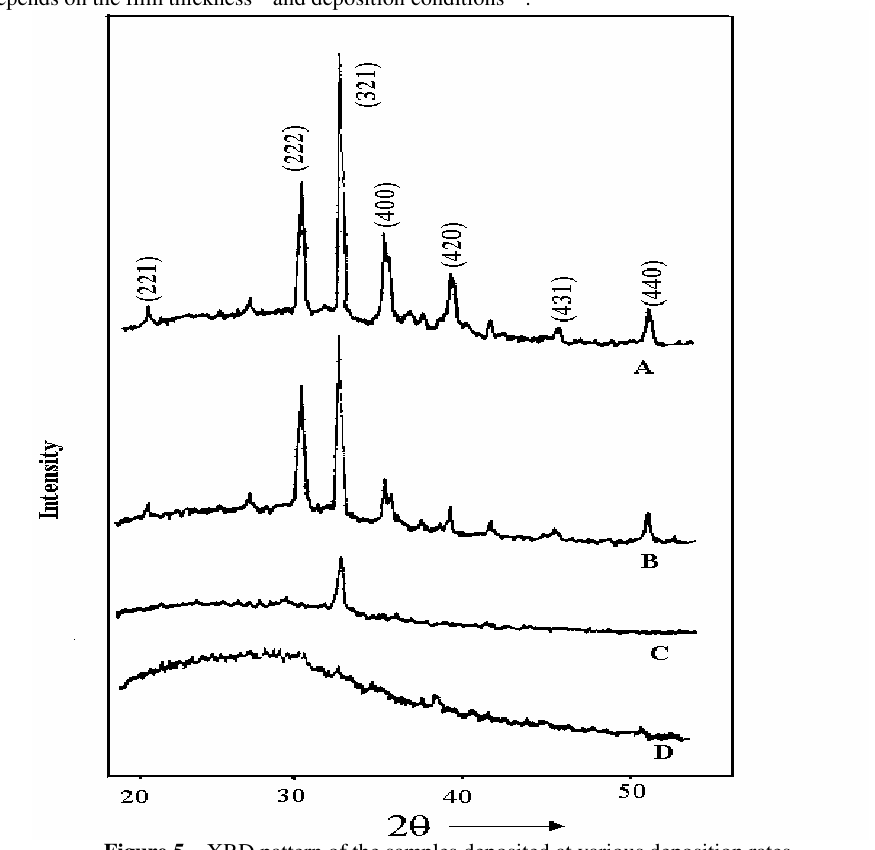
Figure 5 . XRD pattern of the samples deposited at various deposition